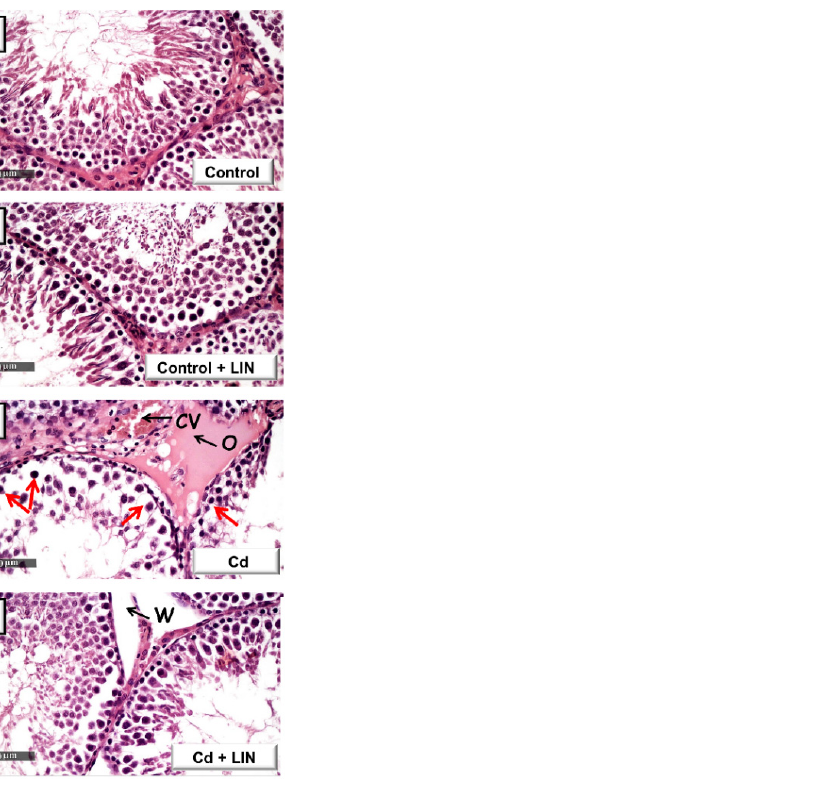
Figure 2. Effect of cadmium and/or linagliptin administration on the testicular histomorphological changes in rats. The testicular cross-sections were stained with hematoxylin and eosin (H&E) stain and examined using light microscopy. Normal morphology of seminiferous tubules and complete spermatogenic series were evident in the control ( A ) and linagliptin-treated control group ( B ). Atrophy of the seminiferous tubules, germinal epithelium degenerative changes (red arrow), moder- ate interstitial edema (O), and severely congested blood vessels (CV) were observed in cadmium- intoxicated sections ( C ). These histopathological lesions were attenuated in the testicular sections from the linagliptin-treated testicular damage group ( D ). Yet, widening (W) of interstitial spaces was still seen. Three animals were randomly chosen from each experimental group for histopathology. LIN, linagliptin; Cd, cadmium